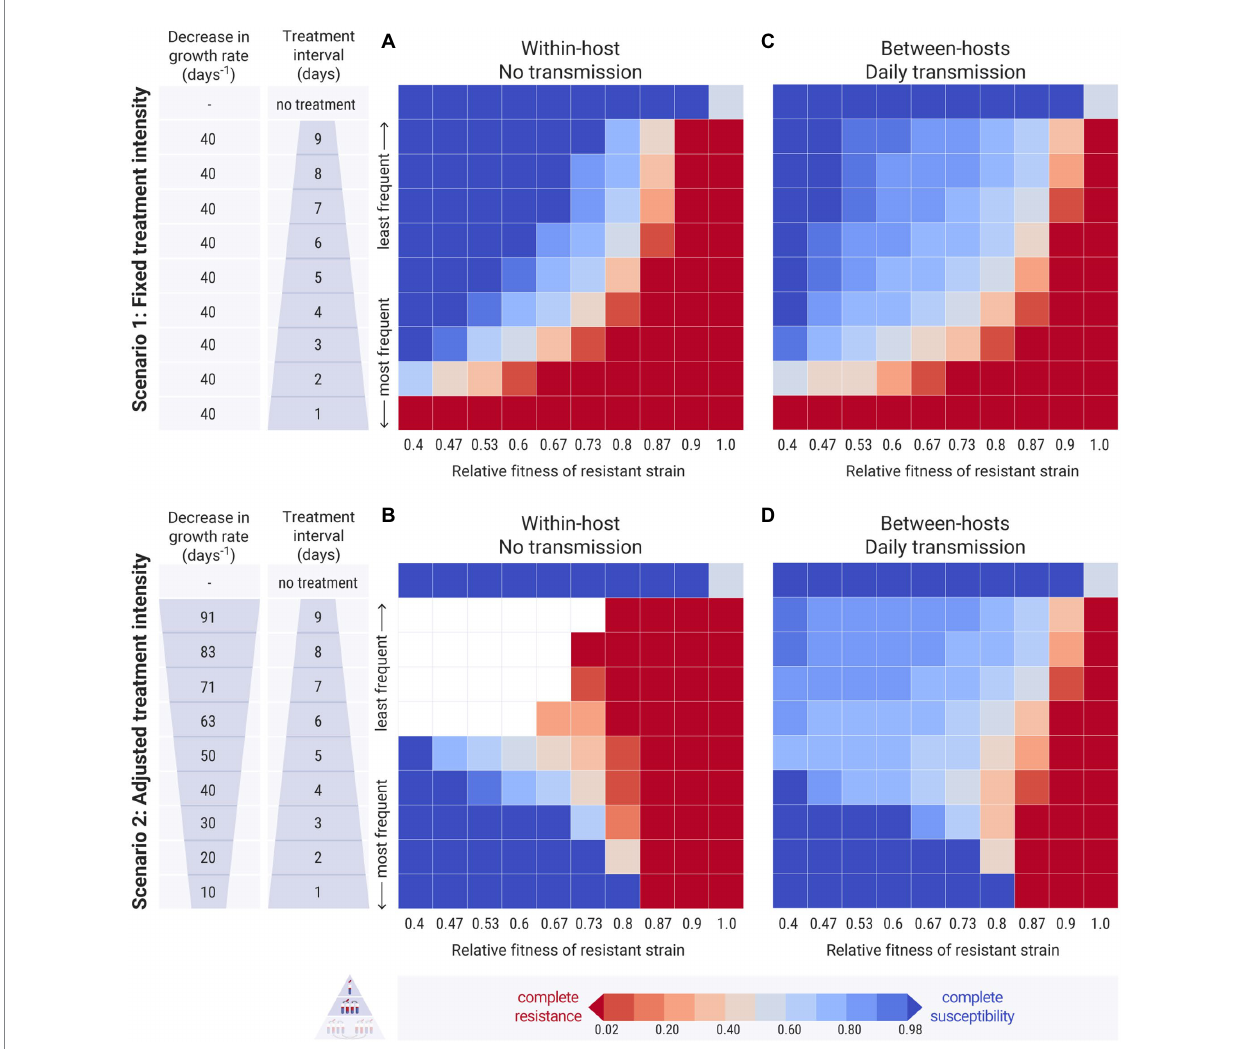
FIGURE 4 Results of the simulations across different treatment intervals ( I antim , y -axis) and relative fitness of the resistant strain ( w , x -axis). Each cell of the heatmap represents the equilibrium values of one experiment. The colour bar represents the average equilibrium ratio of susceptible bacteria in the host or in the host population. (A , C) Scenario 1, where the decrease in the intrinsic growth rate due to the antimicrobial treatment is fixed across experiments at 40 d Smax = day − 1 . (B , D) Scenario 2, where the decrease in the growth rate due to the antimicrobial treatment, d Smax , is adjusted by the treatment interval, and takes values between 10 and 91 day − 1 (see Supplementary Table S1 for calculation). (A , B) Within-host simulations (no transmission). (C , D) Between-host simulations (with daily